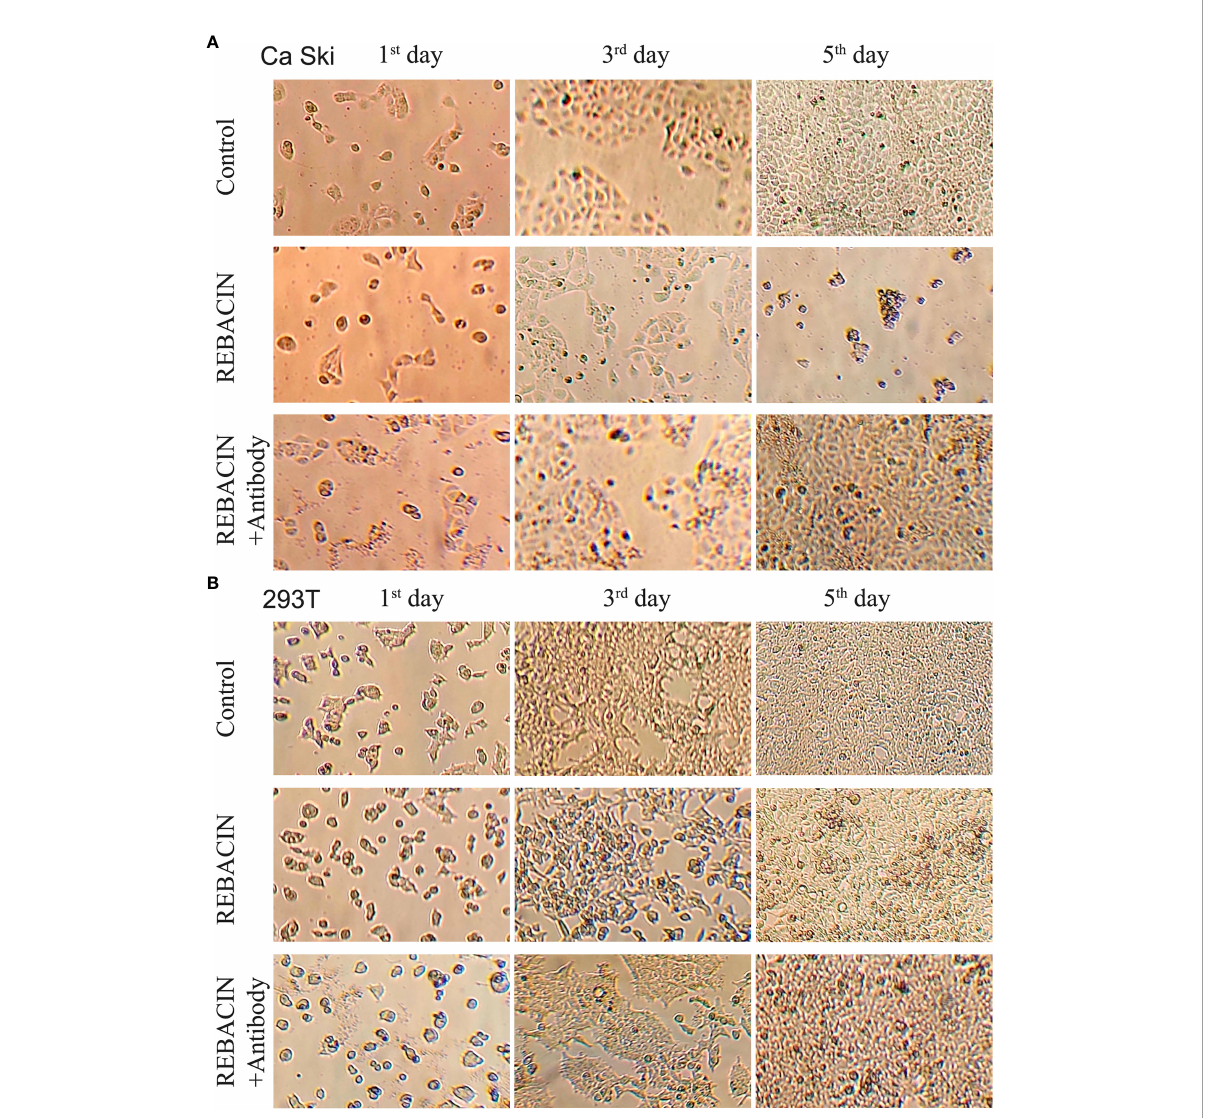
FIGURE 1 Effect of REBACIN ® on the growth of different cell lines. Ca Ski (A) or 293T (B) cells in 24-well plate were treated or not treated by 50 m g/ml REBACIN ® or REBACIN ® /anti-REBACIN ® antibody for up to 6 days, and the representative images in the 1 st , 3 rd , and 5 th day were